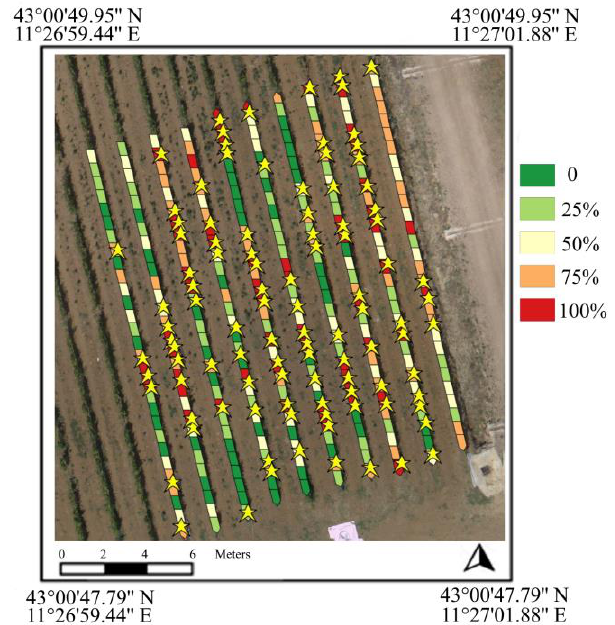
Figure 6. Map of missing plant classification. Level of potential missing plants: 100% (red), 75% (orange), 50% (yellow), 25% (light green) and no missing plants (dark green) at Site C.